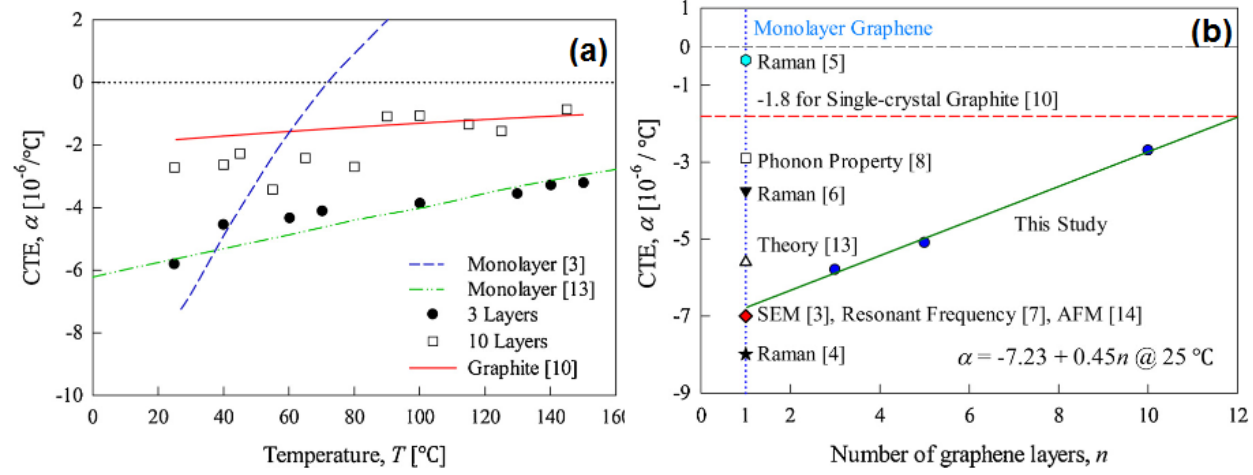
Figure 4. The thermal properties of the graphene-based flakes: ( a ) coefficient of thermal expansion against temperature; ( b ) coefficient of thermal expansion against mono-, few-, and multi-layer graphene. Reproduced from [15] with the permission of Elsevier.